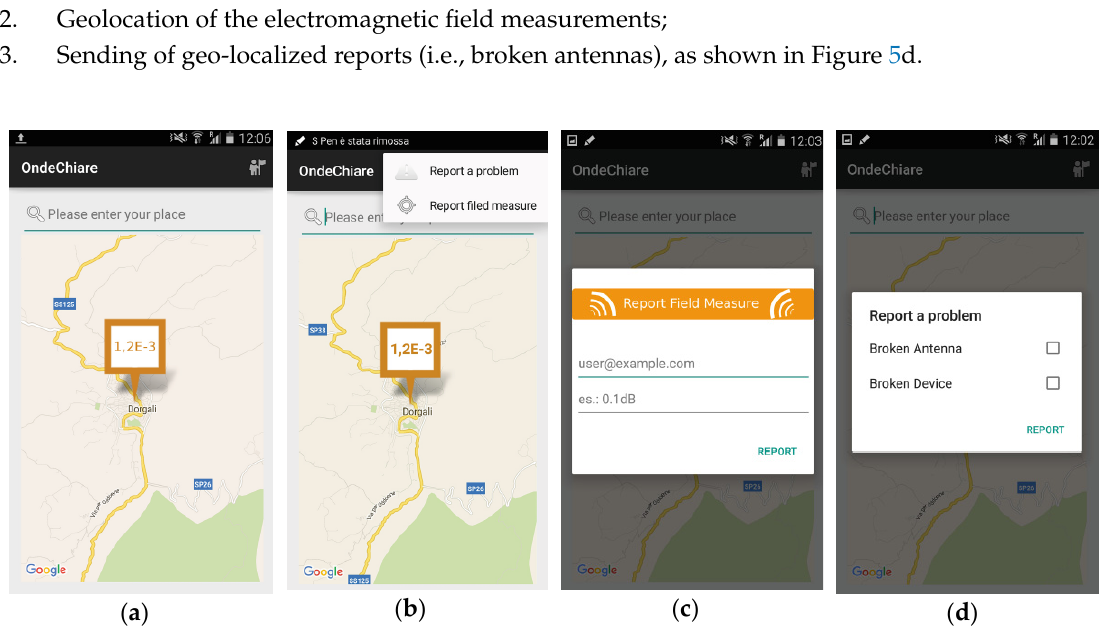
Figure 5. Examples of the app functionalities. ( a ) Main screen: the mobile user position is presented in the Google maps environment. ( b ) Report Menu. ( c ) User-suggested field measures for enhanced feedback. ( d ) Screen of the reported diagnostic tool.